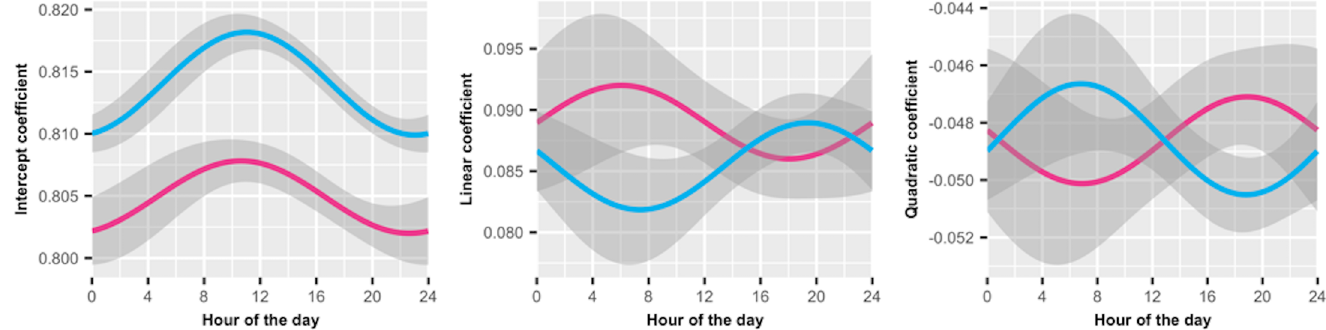
Fig 5. Time of day predicting the intercept, linear, and quadratic coefficients for within task fatigue. Notes: Sample 1 is red, Sample 2 is blue. Shadedregionsrepresent 95% confidenceintervals. Plots revealthat (A) there is a daily pattern for session score at the beginning of the session (Intercept term) but no significantor consistent pattern for either the (B) linear or (C) quadratic terms definingwithin-session fatigue.